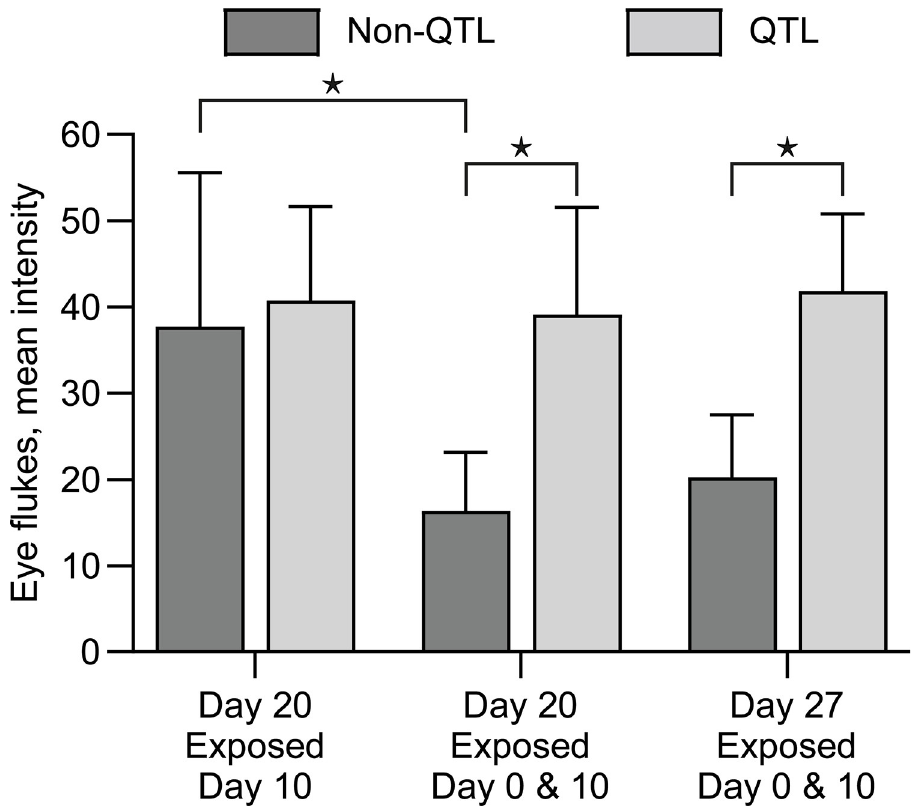
Fig 3. Eye fluke mean intensity in QTL and non-QTL fish on 20 and 27 days post exposure for Group 1 (exposed on days 0 and 10) and Group 2 (exposed only on day 10). � : p < 0.05. https://doi.org/10.1371/journal.pone.0276895.g003 Comparing fold change between infected QTL and non-QTL fish gill in different time points showed a significant upregulation in non-QTL fish for genes encoding C3, Fox P3a, IFN γ , IgDs, IgM, IL-2 and IL-12 on 7dpe (S2 Table and S1 Fig).